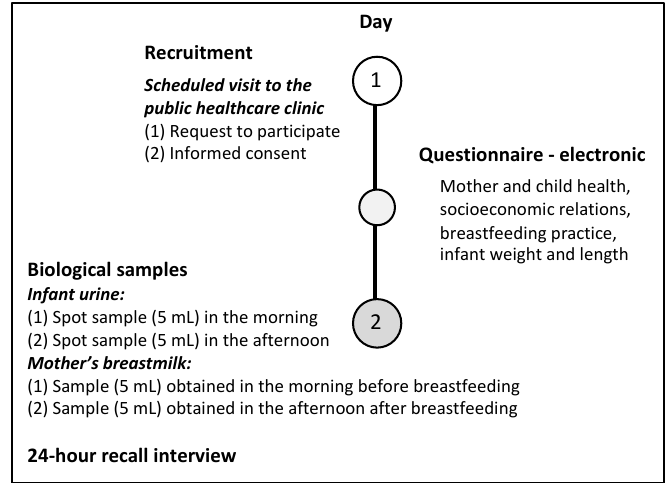
Figure 1. Data collection procedure.